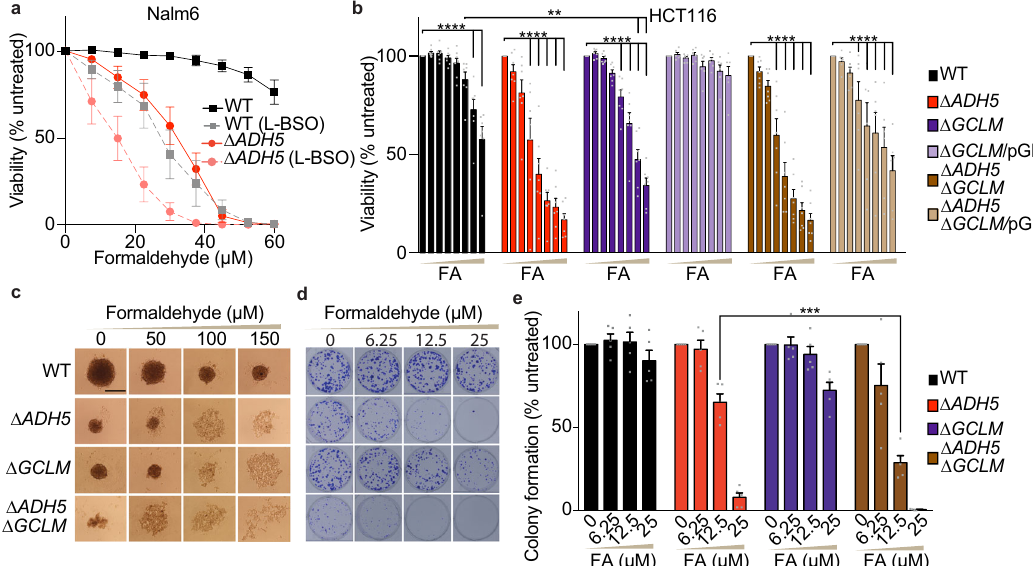
Fig. 5 GSH biosynthesis limits formaldehyde toxicity. a Resazurin-based viability assay in Wild type (WT) and Δ ADH5 Nalm6 cells in the presence of different concentrations of formaldehyde (FA) with or without 50 μ mol L − 1 L-buthionine-sulfoximine (L-BSO) for fi ve days (mean ± SEM, n = 6). µ M refers to µ mol L − 1 . b Resazurin-based viability assay performed with WT, Δ ADH5 , Δ GCLM and Δ ADH5 Δ GCLM ( n = 7) HCT116 cells and with the complemented cell lines Δ GCLM /pGCLM (pGM) and Δ ADH5 Δ GCLM /pGCLM (pGM) ( n = 6) in response to 0, 15, 30, 60, 90, 120, 150 and 180 μ mol L − 1 FA ( n =